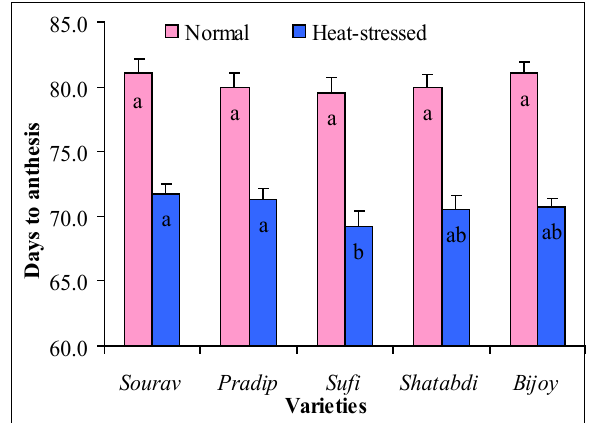
Fig. 4. Days to anthesis of different wheat varieties under normal and heat stressed condition. Mean (±SD) was calculated from three replicates for each treatment. Bars with different letters are significantly different at P < 0.05 applying LSD